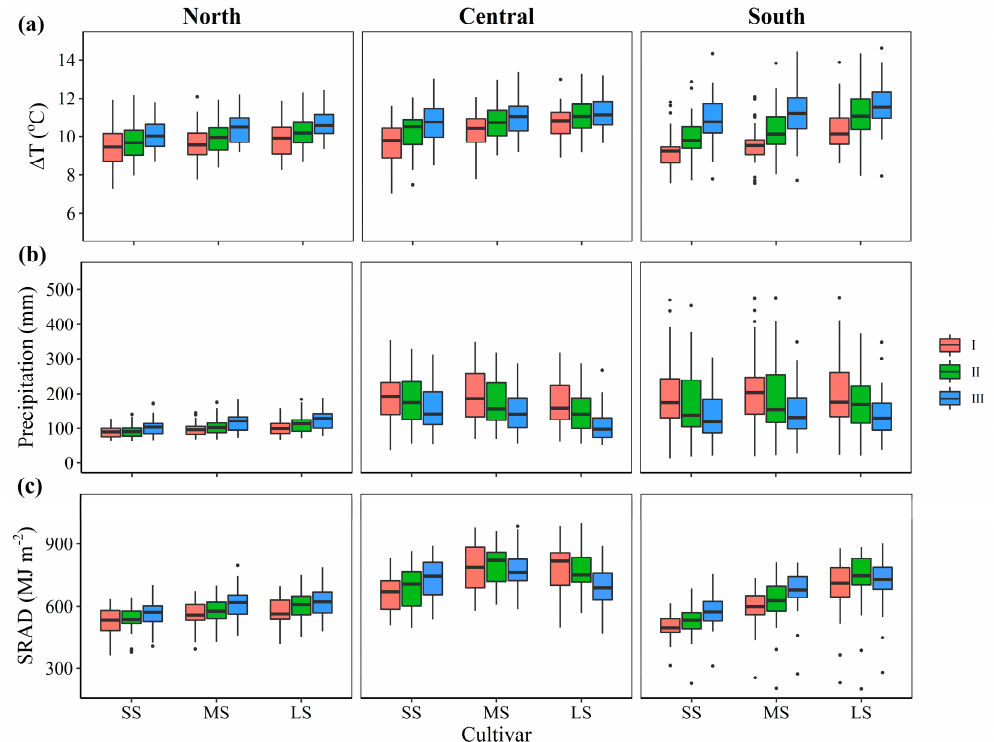
Figure 6. The diurnal thermal range ( ∆ T, ( a )); precipitation ( b ), and solar radiation (SRAD, ( c )) of grain-filling stage at different maize cultivars and sowing dates from 1980 to 2019. North: Keshan station; Central: Gongzhuling station; South: Shenyang station; SS: short-season cultivars; MS: medium-season cultivars; LS: long-season cultivars; I: early sowing date; II: medium sowing date (traditional sowing date); III: late sowing date.